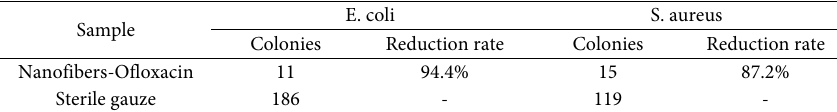
Table 1: Antimicrobial activity of nanofibers-Ofloxacin